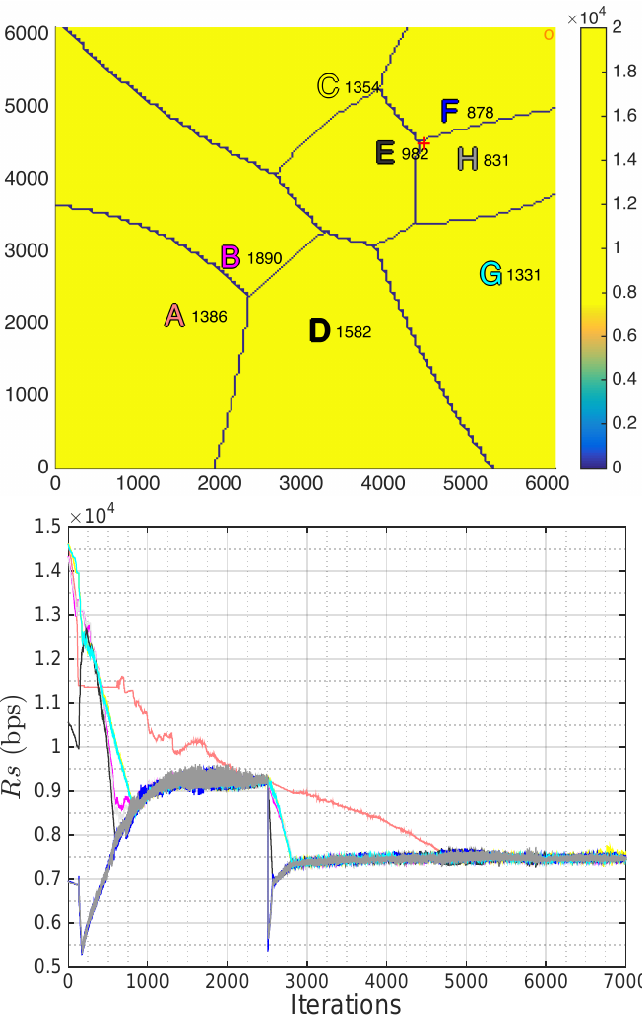
Figure 6. Rearrangement of UAVs when one UAV decays: positions and coverage areas ( top ); and evolution of the rate per user in each coverage area ( bottom ). Each color in the bottom figure represents one coverage area using the same colors as the ones assigned to letters in the top